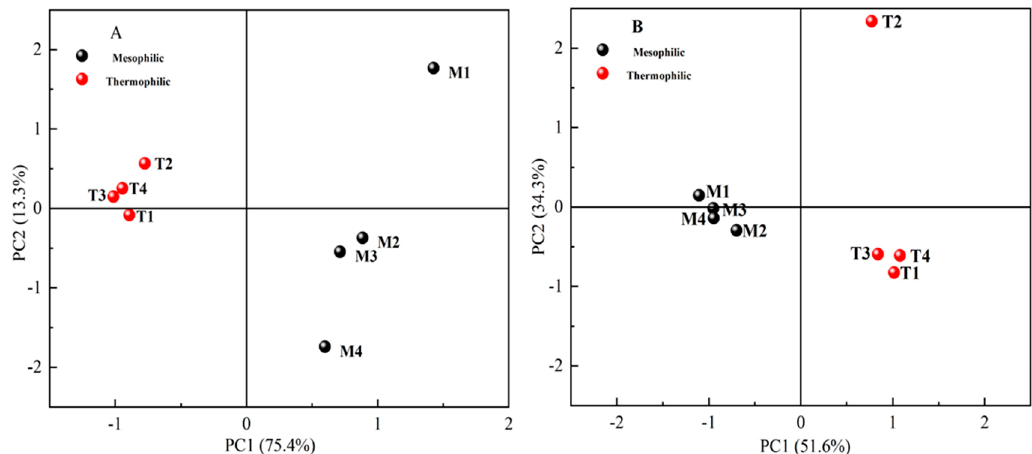
Figure 5. Principal component analysis (PCA) of bacterial ( A ) and archaeal ( B ) operational taxonomic unit (OTU) distribution generated by 16S rRNA gene sequencing.